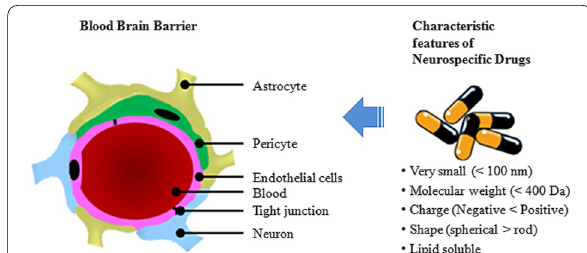
Fig. 1 Characteristics of neurospecific drugs. The BBB is typically made up of the tight junctions in the endothelial cells surrounded by the astrocytes, pericytes and neurons. Neurospecific molecules should possess specific characteristics to be able to cross the blood– brain barrier (BBB). Preferred characteristics are: very small size with a diameter of less than 100 nm, low molecular weight preferably less than 400 Da, should be positively charged, spherical in shape and lipid